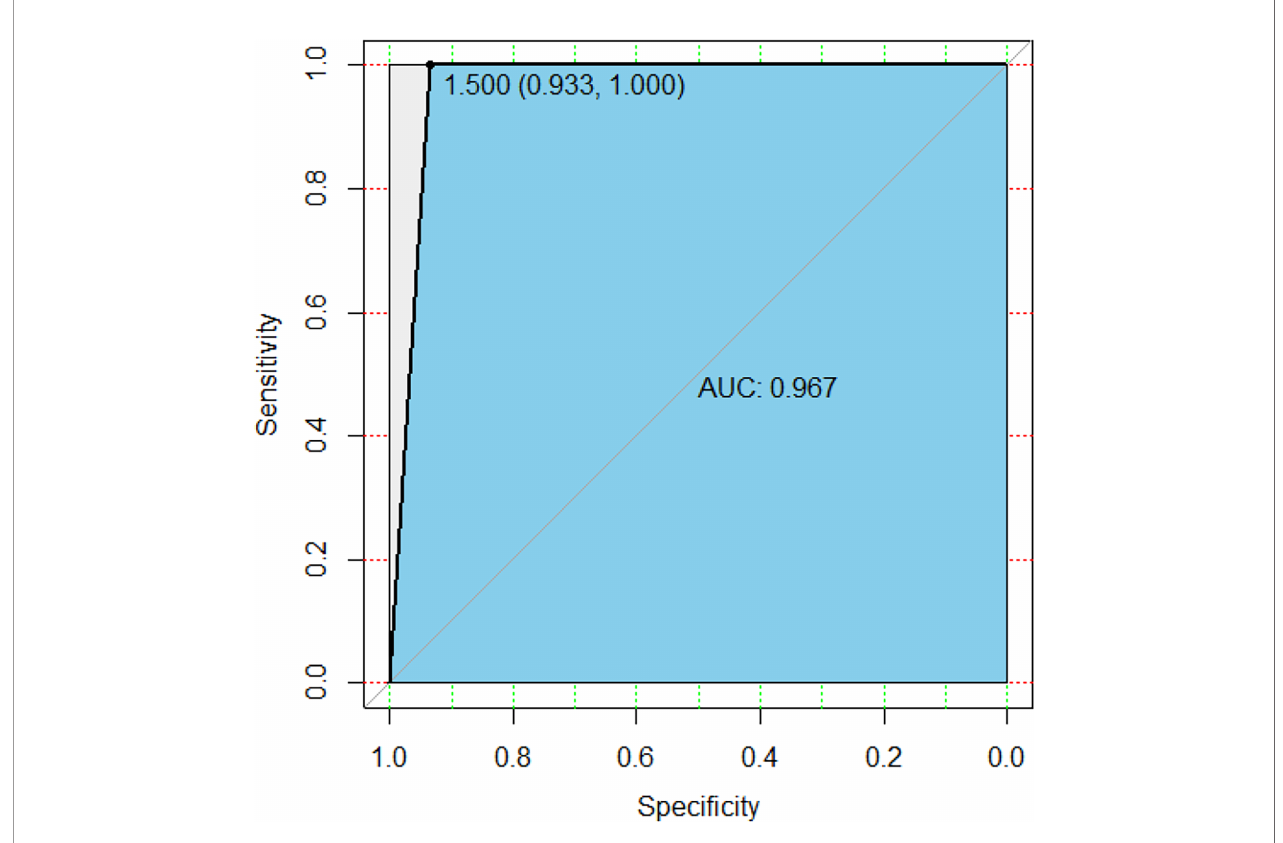
FIGURE 6 | ROC curve and AUC area of random